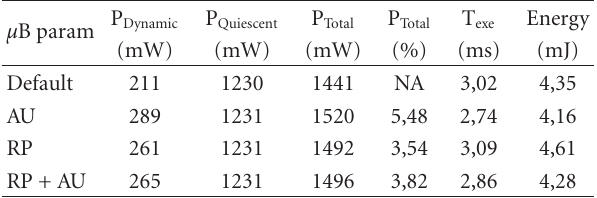
Table 8: Impact of the MicroBlaze configurations for the ANN algorithm at 100 MHz for V4FX100.